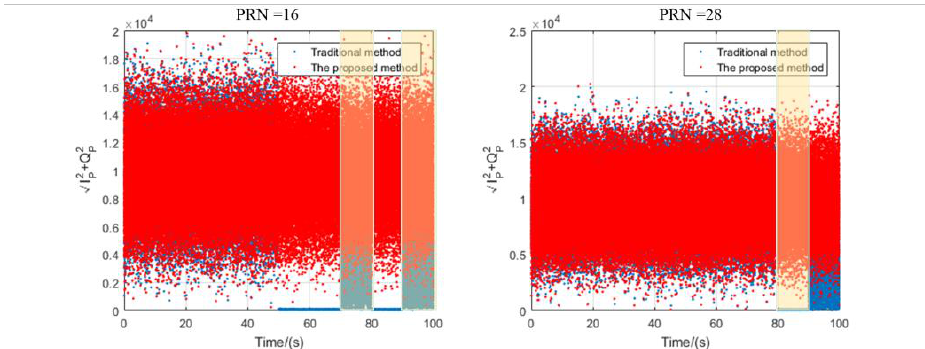
Figure 8. The signal mean square value of the prompt IQ branch.